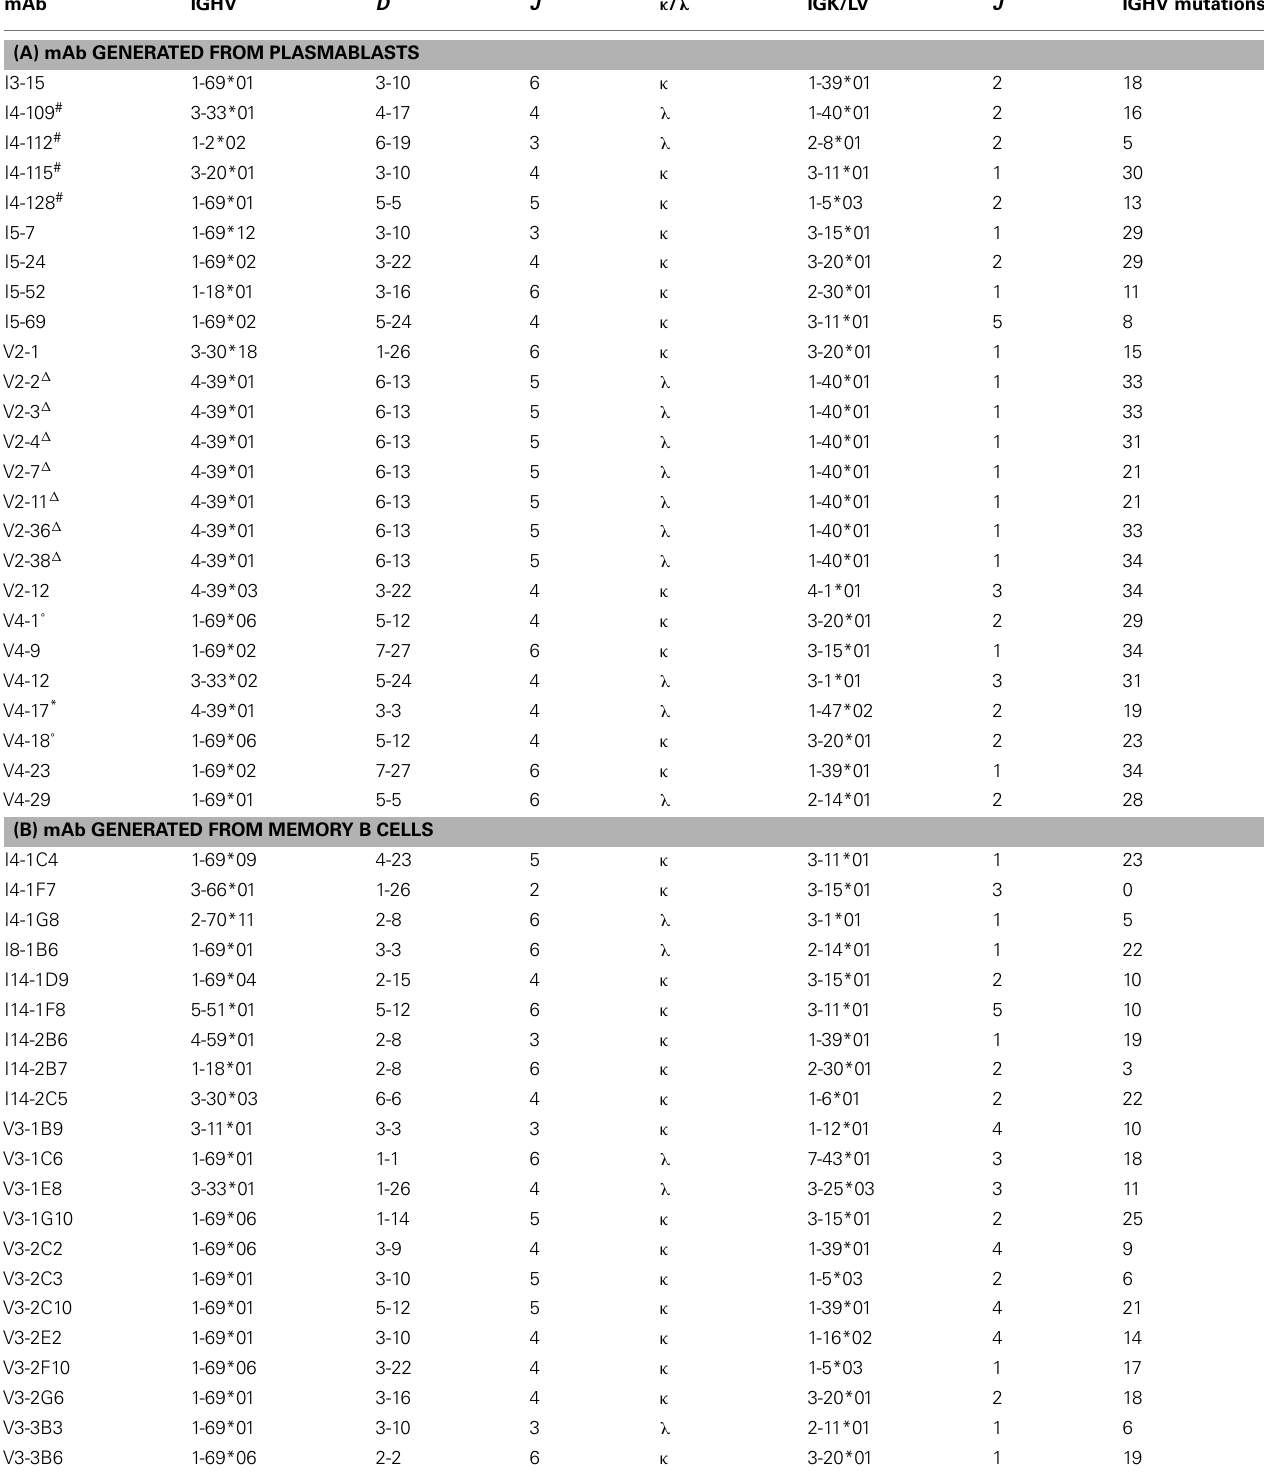
Table 1 |Truly human monoclonal antibodies binding to pdmHA.